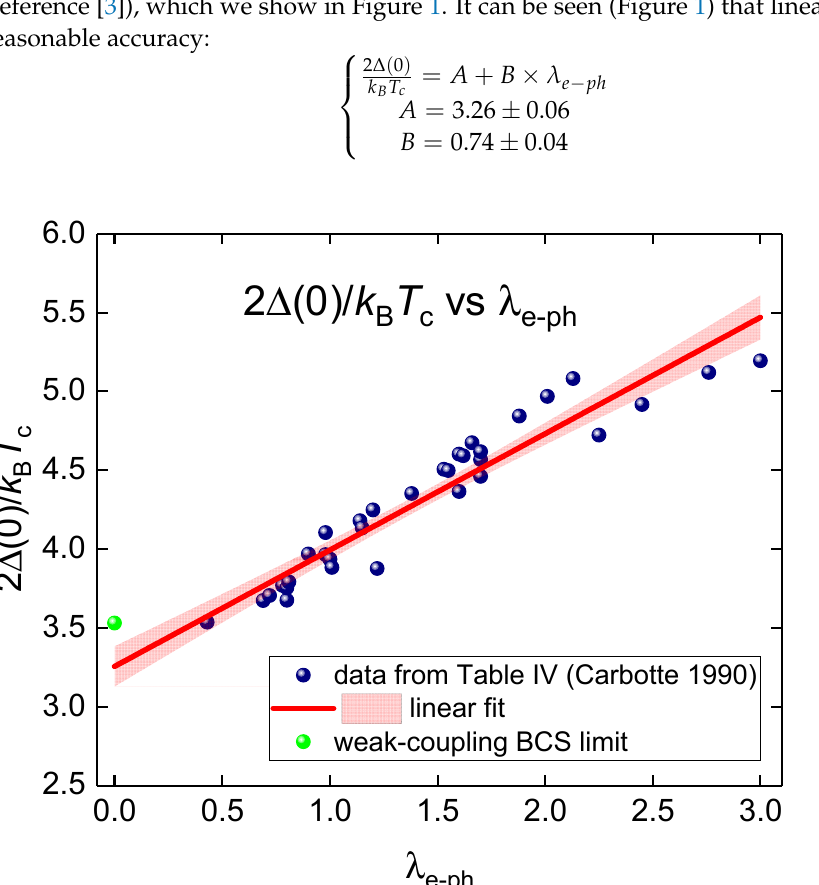
Figure 1. The electron–phonon coupling constant λ e − ph vs. the gap-to-transition temperature ratio 2 · ∆ ( 0 ) (data is taken from Table IV of Reference [3]) and data fit to Equation (10). Deduced parameters are: A = 3.26 ± 0.06 and B = 0.74 ± 0.04. BCS weak-coupling limit 2 green ball. 95% confidence bands are shown by pink shadow area. Goodness-of-fit is R = 0.912.